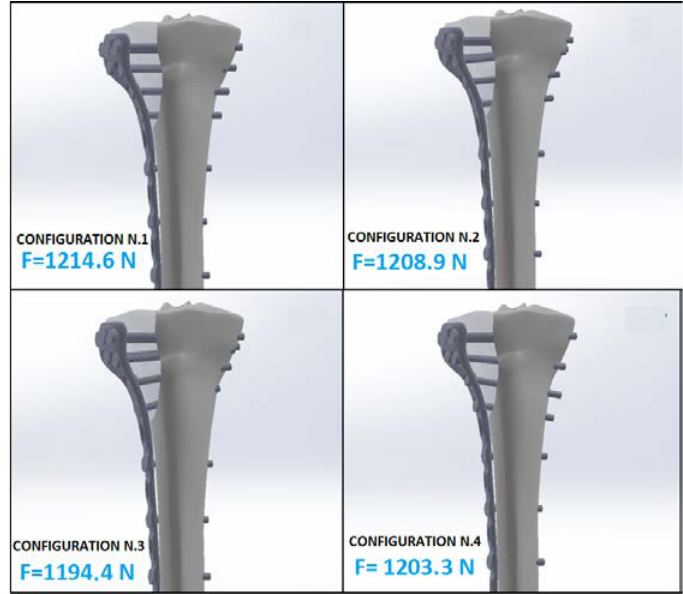
Figure 10. Calculated reaction forces (F) at the distal tibia for the analysed configurations.